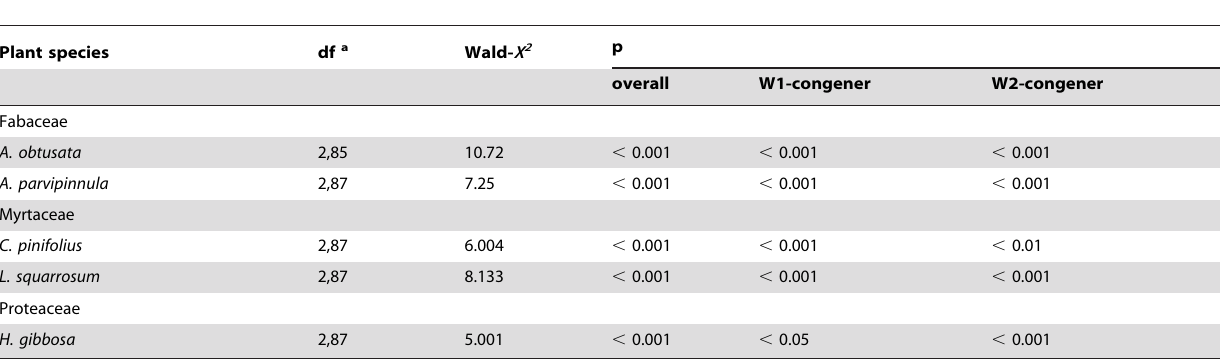
Table 5. Summary statistics for multivariate generalised linear model analyses (mGLM) of feeding guild species richness data, for only the herbivore Coleoptera and Hemiptera guild structure; pair wise comparisons between the two warm sites and a congeneric host plant species in this area are